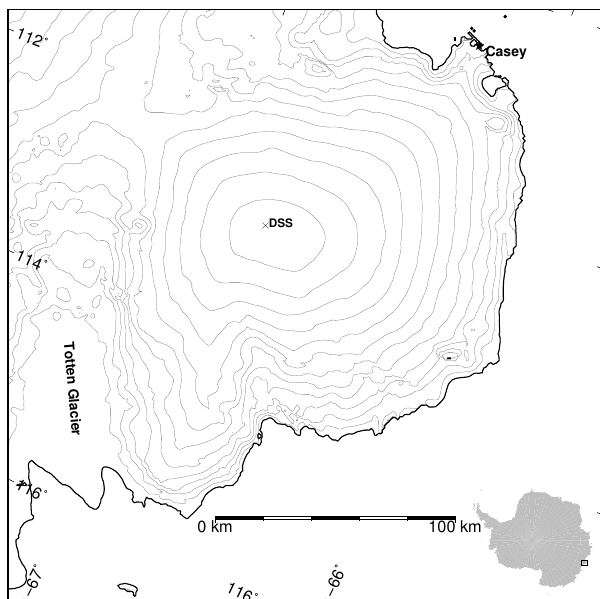
Figure 1. Law Dome, East Antarctica and the location of the Dome Summit South (DSS) borehole. Also shown are 100m surface ele- vation contours from Bamber et al.